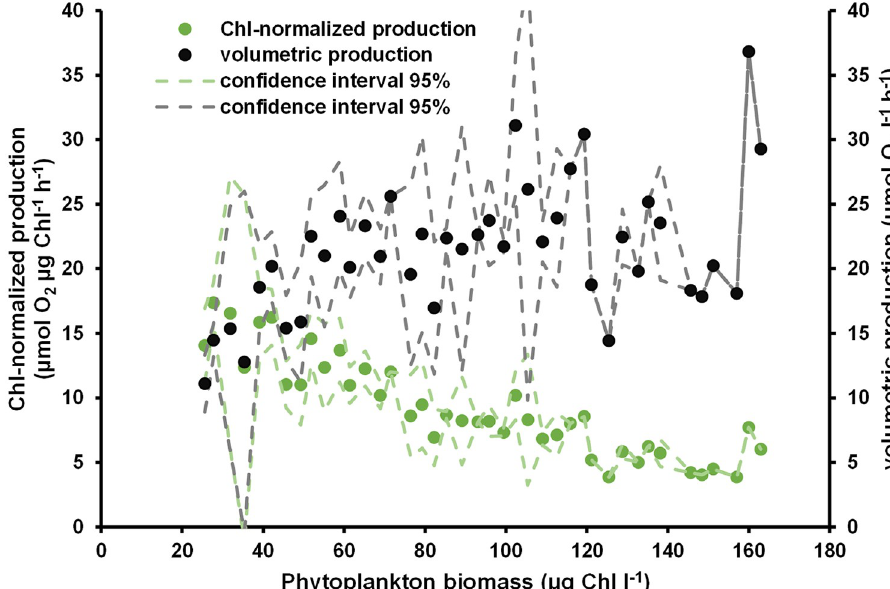
Fig 2. Chl-normalized ( μ mol O 2 μ g -1 Chl a h -1 ) based on phytoplankton biomass (Chlorophyll a μ g l -1 ) and volumetric ( μ mol O 2 l -1 h -1 ) hourly oxygen production in phytoplankton mesocosms. Production values represent averaged hourly values calculated from daily production values divided by hours of daylight. Confidence intervals are based on standard deviations of pooled, averaged Chl-concentrations (interval steps at 3 μ g l -1 ).